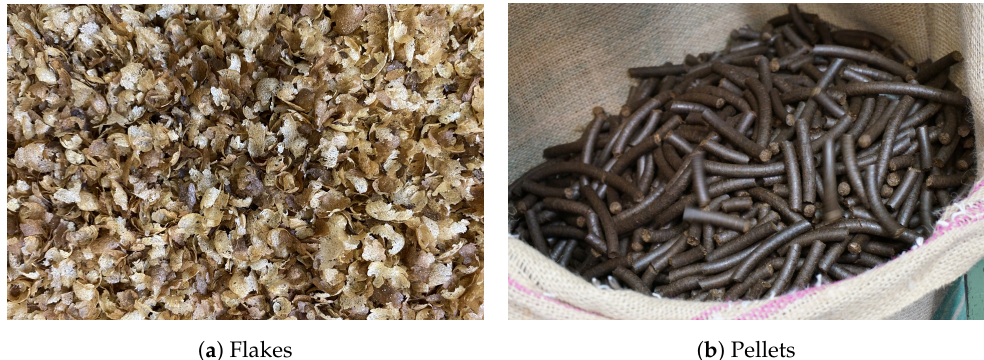
Figure 2. Processed silver skin. ( a ) Silver skin as flakes. ( b ) Silver skin pressed into pellets. (Photos by the authors).